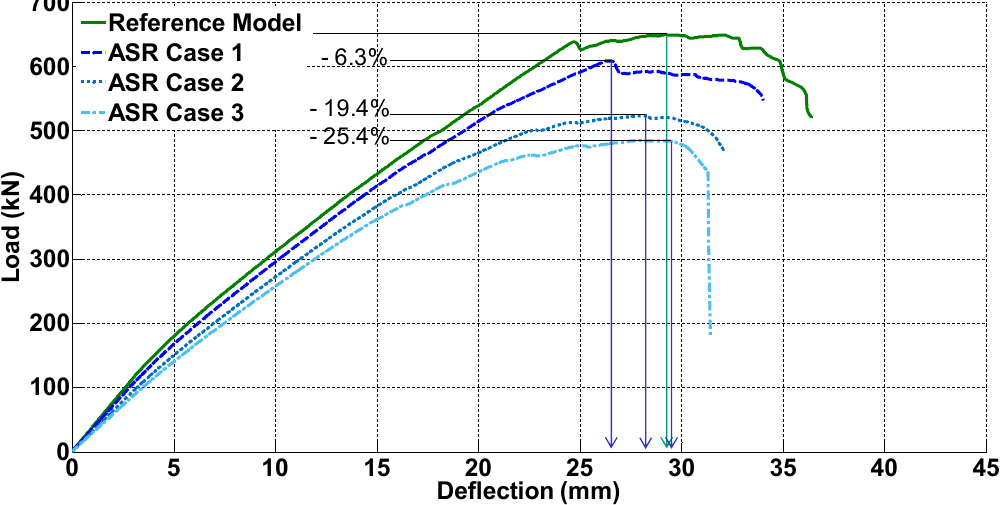
Figure 15. Load versus deflection diagram for different levels of ASR degradation.